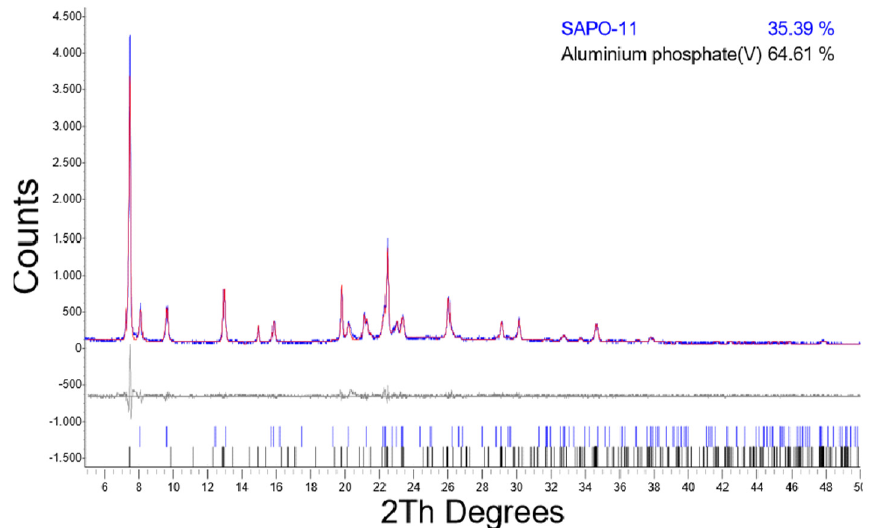
Figure A2. Rietveld refinement plot for 24/SH: the vertical lines provide the positions of all possible Bragg reflections for the aluminum phosphate(V) phases (database_code-ICSD 88566) and structure of zeolite type AEL (database_IZA). The values of the standard agreement indices are Rp—8.58, Rwp—11.22, Rexp—8.35, GofF—1.34.